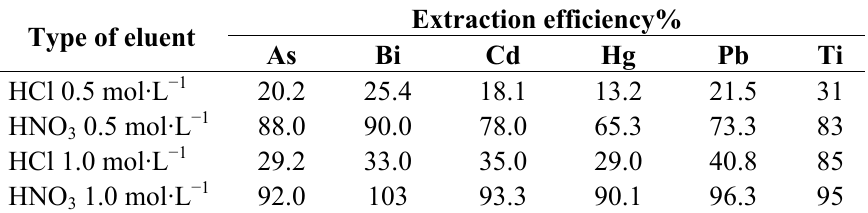
Table 3. Effect of type